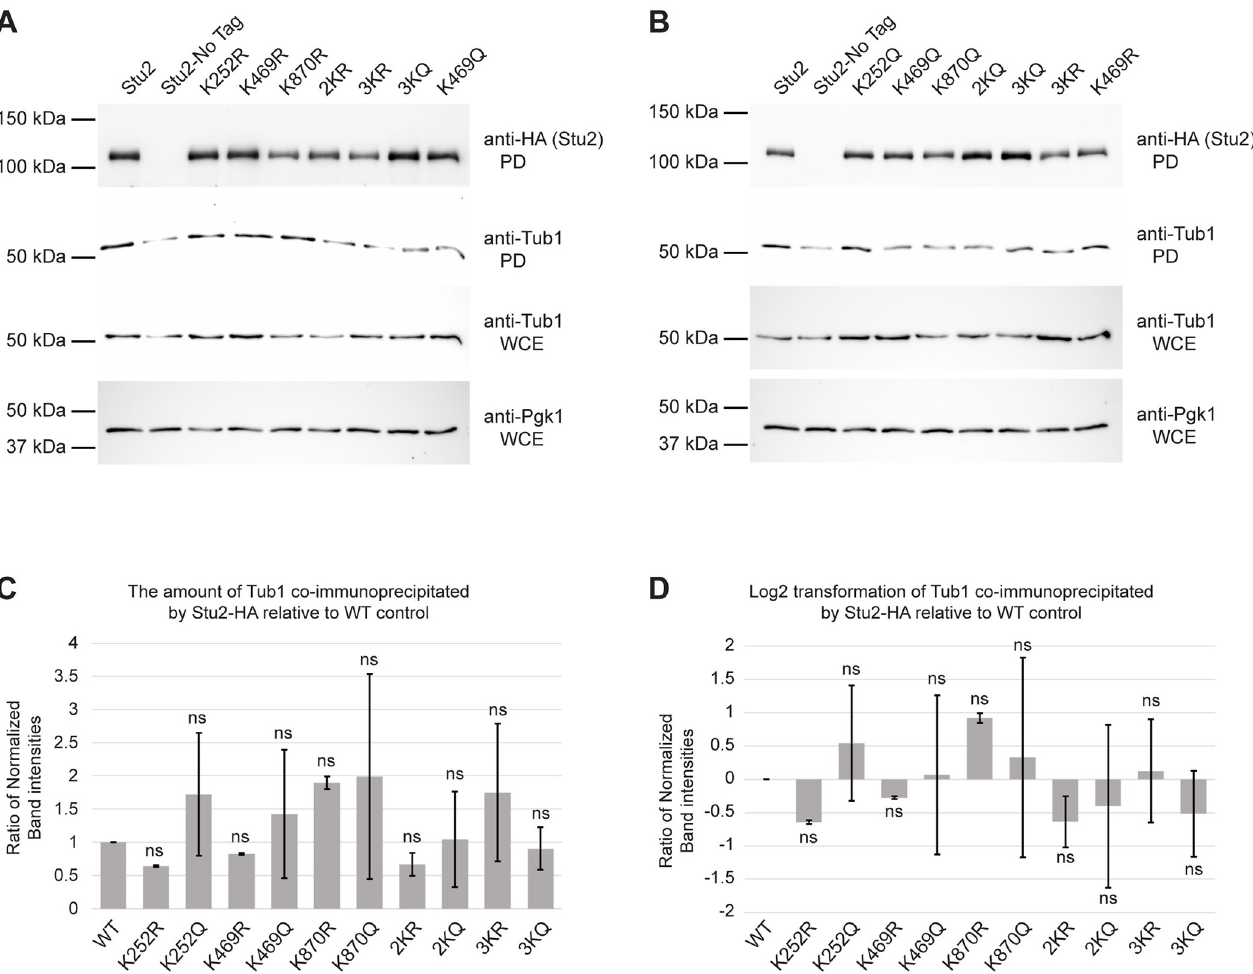
Fig 11. The Stu2 acetyl mutants display no discernable difference in their interactions with αβ -tubulin by immunoprecipitation. (A,B) The yeast described in Fig 10 were used for immunoprecipitations of Stu2::HA in PEM buffer and western blotted. Pull-downs were also probed with anti-Tub1 to detect the amount of αβ -tubulin interacting with the Stu2 mutants. To evaluate α -tubulin abundance and confirm uniform loading of protein, WCEs were western blotted for α -tubulin and Pgk1. (C) To examine the impact of Stu2 acetylation on its interaction with α -tubulin, the ratio of co-immunoprecipitated α -tubulin relative to the enriched Stu2 acetyl-mimetic mutants was evaluated. The error bars represent the mean ± SEM from two biological replicates. The raw quantitative data are available in S1 Supplementary file (D) To illustrate the reductions and increases in the affinities of Stu2 mutants for α -tubulin, the Log2 transformation of ratios for co-immunoprecipitated α -tubulin relative to enriched Stu2 acetyl-mimetic mutants is shown. Ratios of α -tubulin to Stu2-HA acetyl-mutants immunoprecipitated by HA-mag beads displayed as mean ± SEM from two biological replicates. Student’s t-tests performed on densitometry values prior to normalization to WT identified no statistically significant differences in α -tubulin interactions among Stu2 acetyl-mutants. The raw quantitative data are available in S1 Supplementary